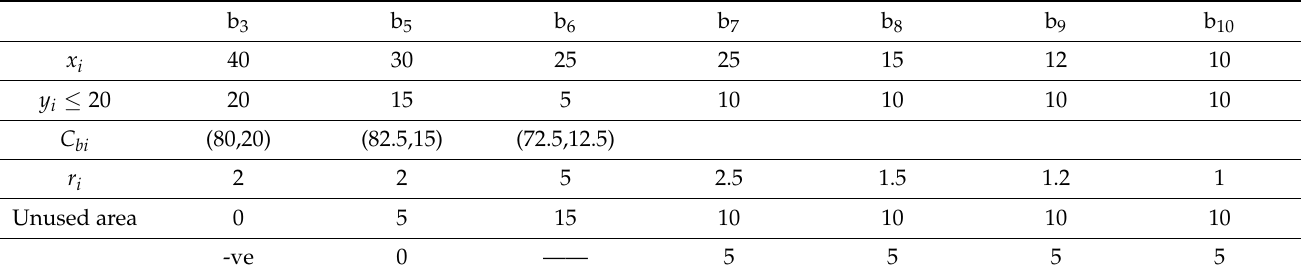
Table 7. Sub-matrix excludes products according to X avi .